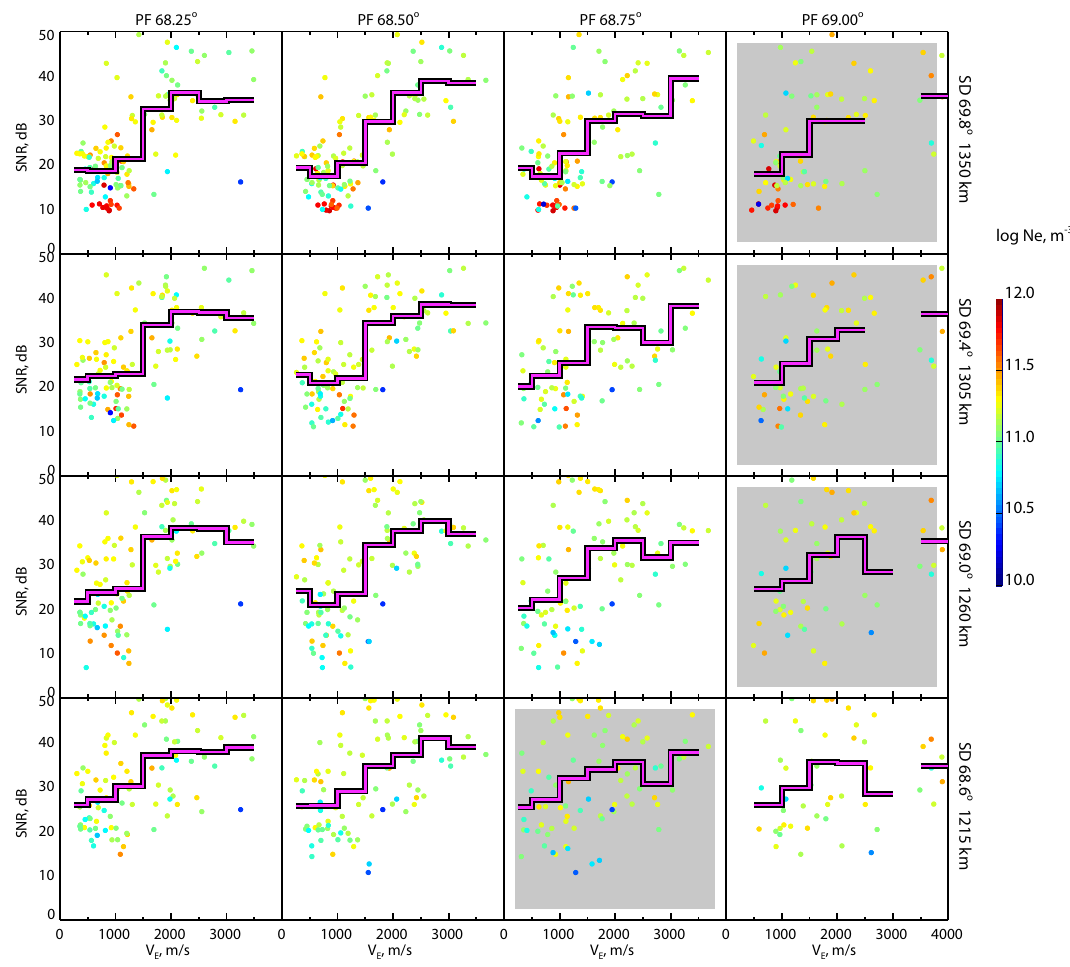
Figure 5. The same as Fig. 3 but for the KOD SNR in beam 3 versus the PFISR convection drift magnitude V E . The color coding is in the PFISR electron density N e at 350km (the same as in Fig. 2e). The thick histogram represents the binned